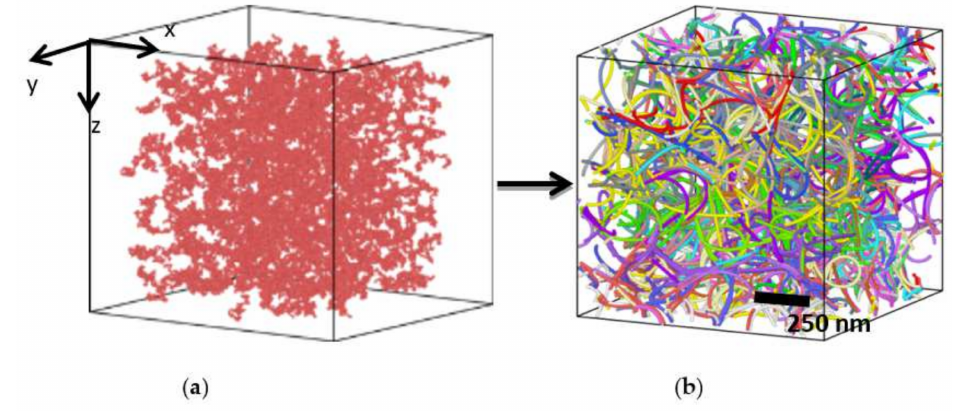
Figure 1. Establishment of a CGMD of buckypaper. ( a ) Random walk; ( b )